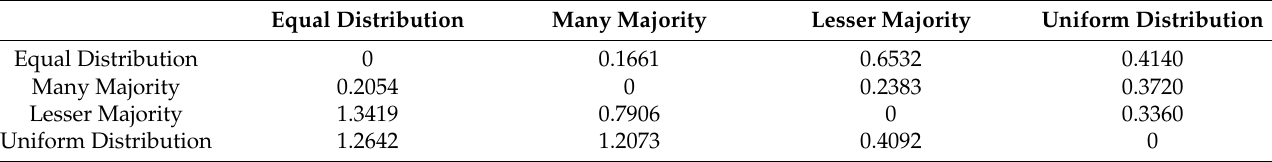
Table 11. KL divergence between the chosen distributions.